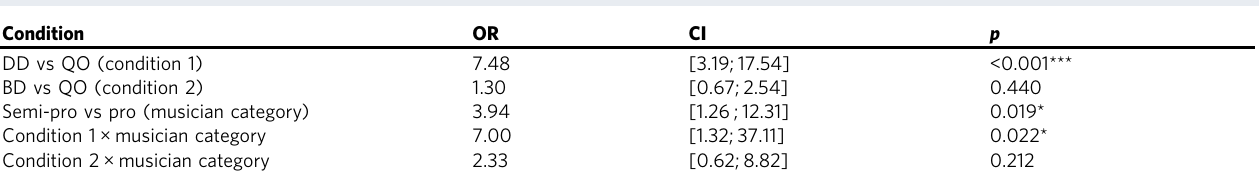
OR denotesoddsratios forthe comparison of different manipulations, musician categories,and their interaction, CI are 95% con fi dence intervalsfor the OR. The p values are markedby *** for p <0.001 and by * for p <0.05. Odds ratio OR = 7.48 for DD vs. QO means that it is about 7.5 times more likely that jazz musicians perceive the downbeat delayed manipulation (DD) as more swinging than the quantized original (QO). BD refers to both delayed, pro and semipro refer to jazz musician